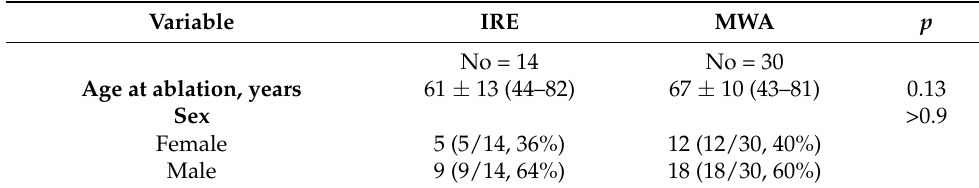
Table 1. Distribution of clinical characteristics by ablation